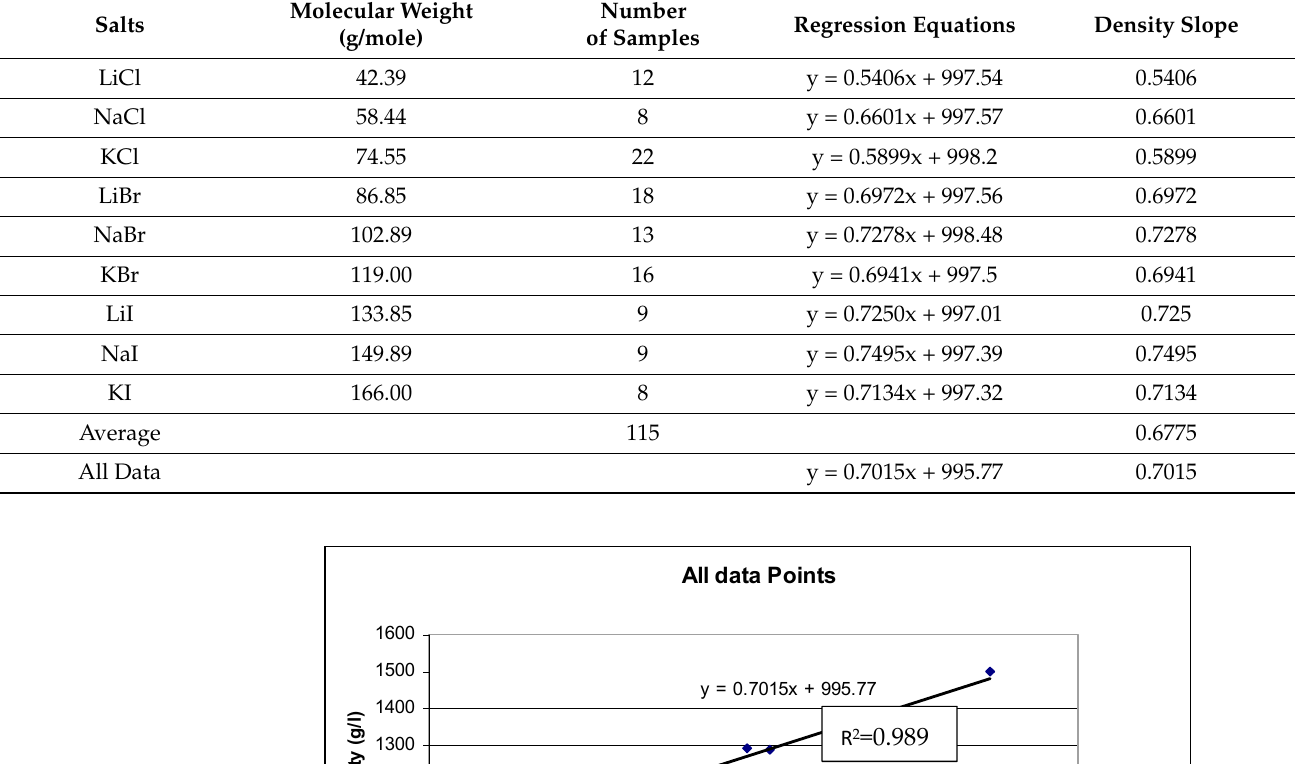
Table 1. Regression analyses of Baxter’s data [3].